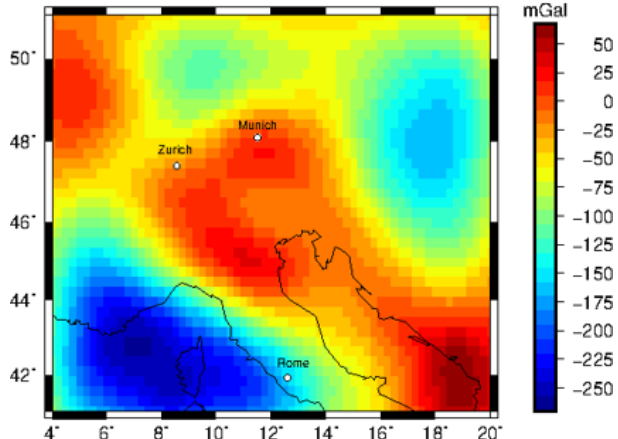
Figure 4. Forward-calculated gravity signal from relative density distribution converted from relative seismic velocities using a con- version factor of 0.3 at a station height of